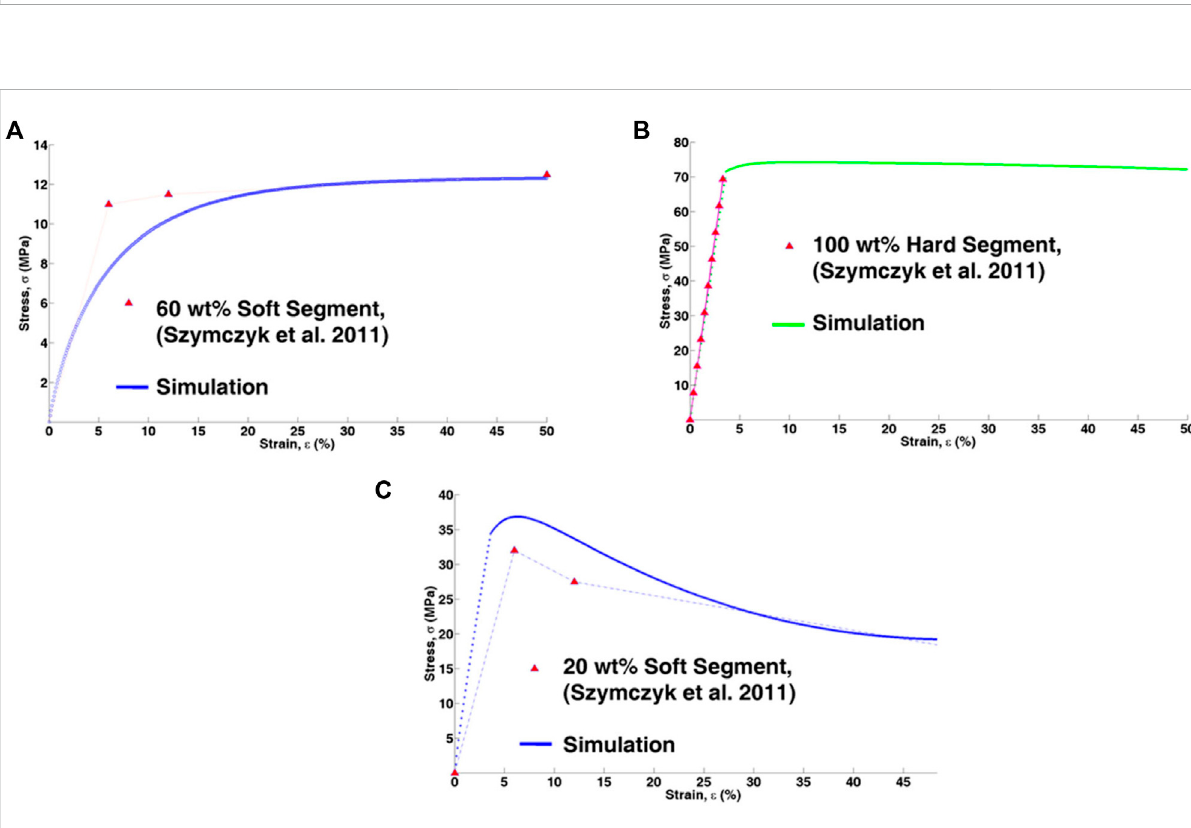
FIGURE 8 (A) Amorphous computation module calibration, (B) crystalline computation module calibration, (C) performance of the model in capturing 20 wt% soft segment tensile test experiment (Szymczyk et al., 2011; Shojaei and Li 2013).[Reproduced with permission from International Journal of Plasticity, 42: 31-49., (2013). Copyright 2013